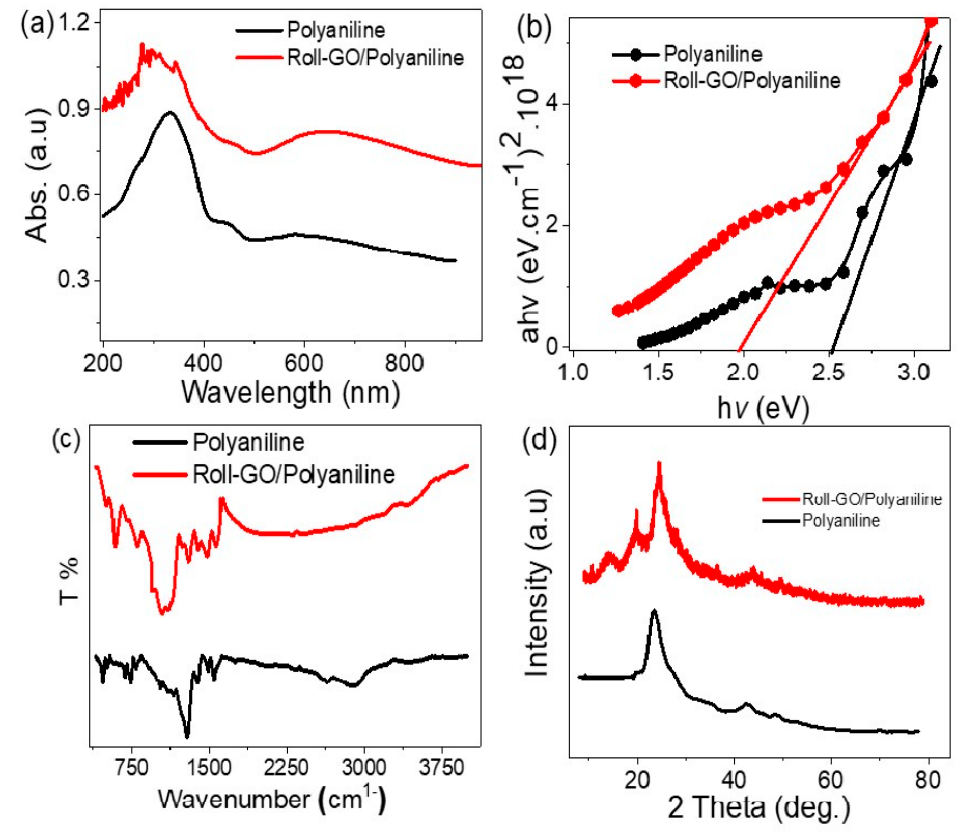
Figure 4. ( a ) Optical, ( b ) bandgap, ( c ) FTIR, and ( d ) XRD of PANI and roll-GO/PANI materials.